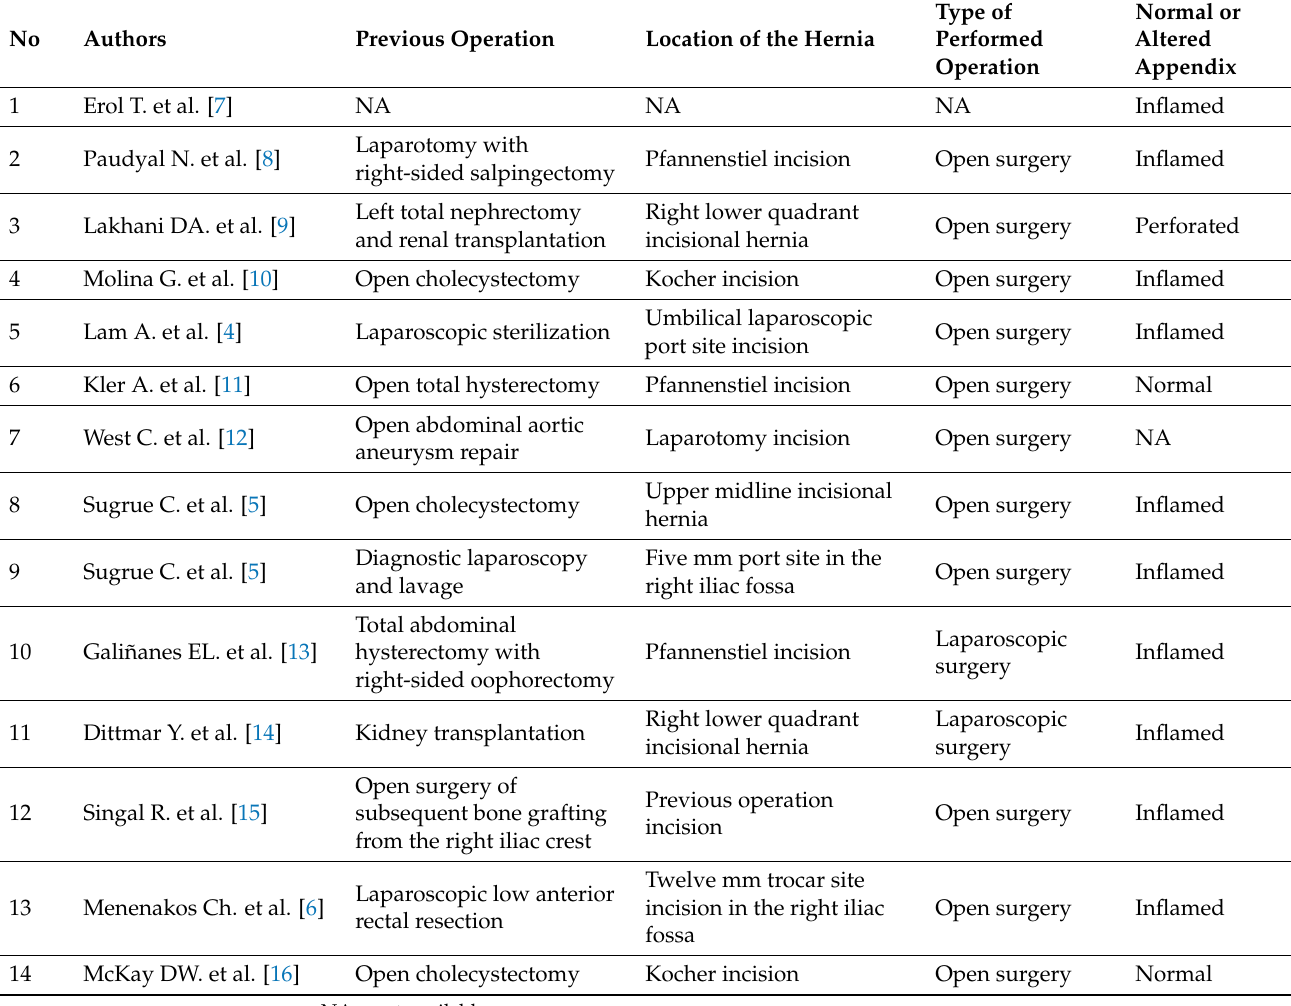
Table 1. Previous cases of appendix within the incisional